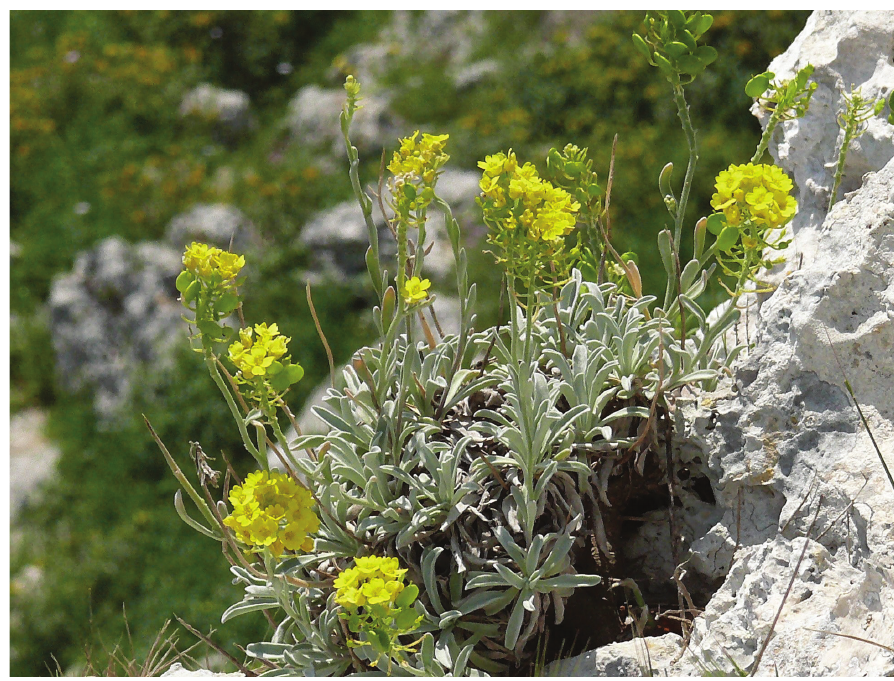
Figure 1. Aurinia leucadea photographed in Torre Minervino (Salento, Italy). Picture by P. Medagli.